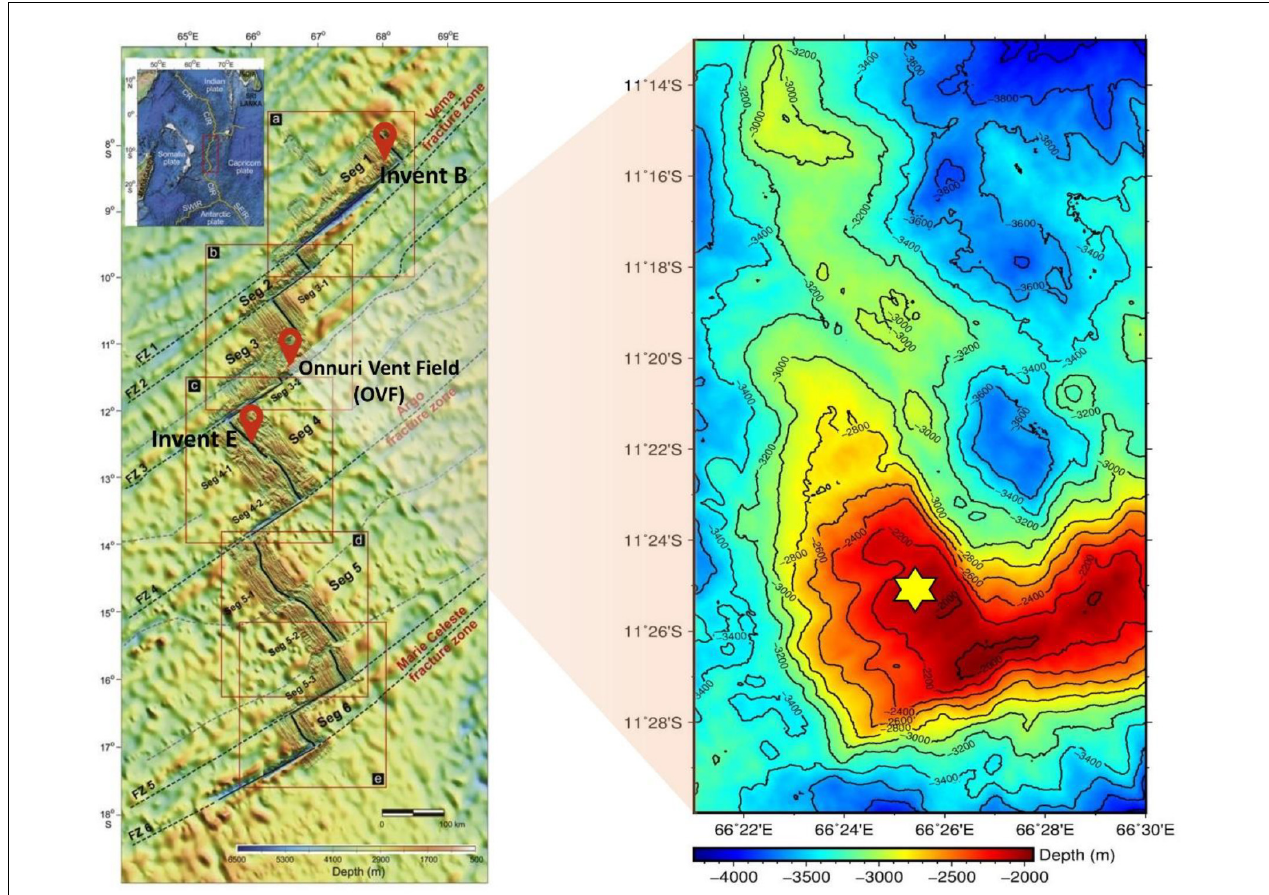
FIGURE 1 | Location of the studied hydrothermal vent fields. Bathymetric map of Invent B, Invent E and Onnuri Vent Field (OVF) located on segment 1, segment 3 and Segment 4 along the Central Indian Ridge [map modified from Pak et al. (2017)]. Sampling site at OVF is noted with yellow